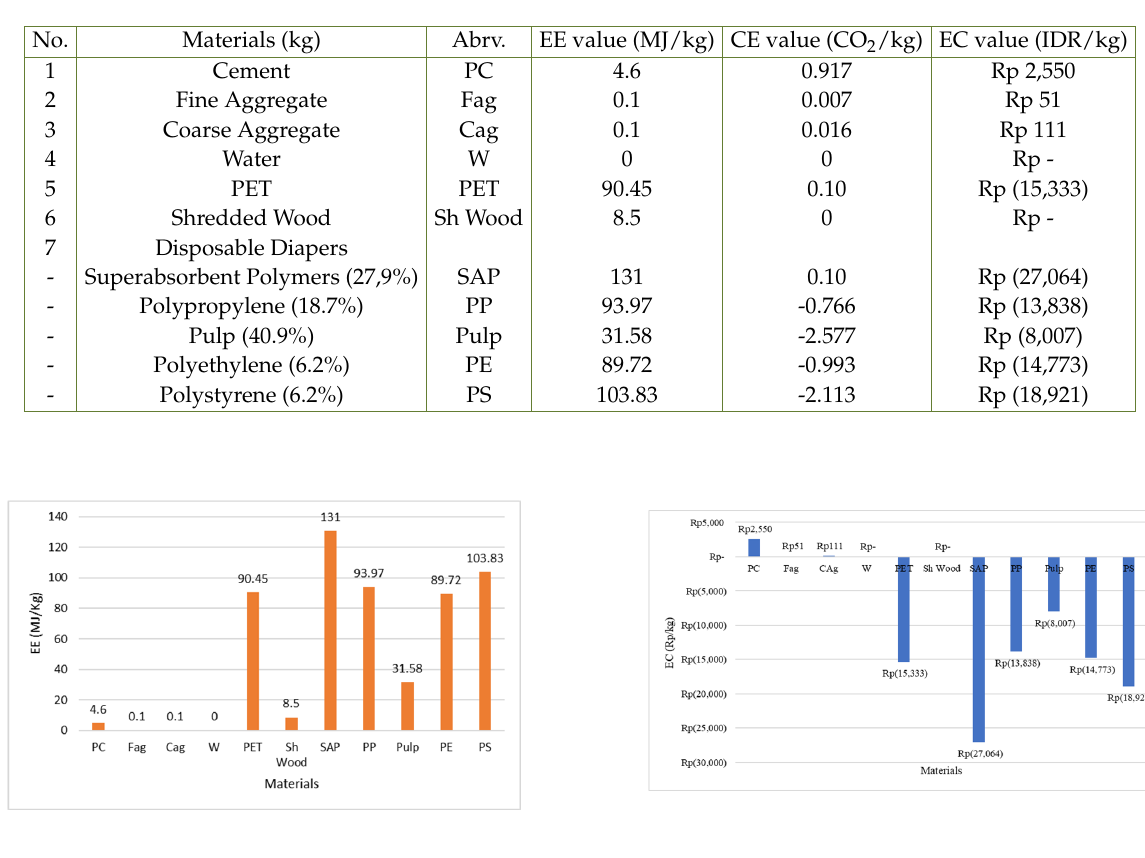
Table 2. EE, CE and EC of 1 kg Materials.